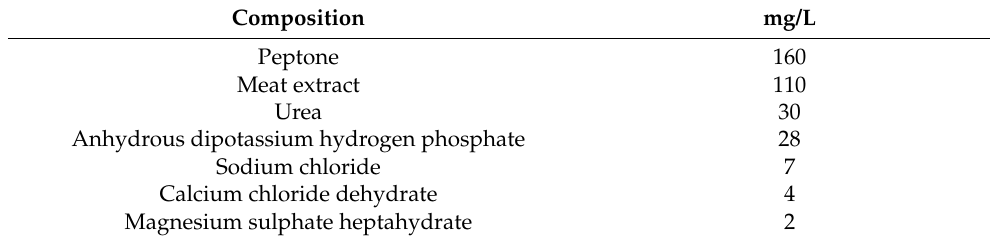
Table 3. Synthetic wastewater influent compositions.